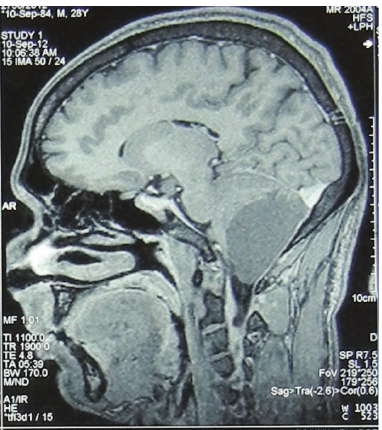
Figure 2: MRI (sagittal view) Showing mass in posterior fossa.